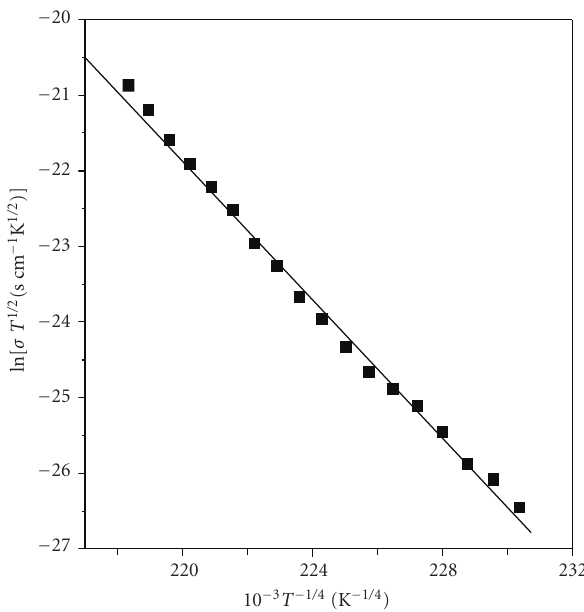
Figure 9: Plot of ln( σT 1 / 2 ) versus ( T − 1 / 4 ) for NFSC within a temperature of 350K–440 K and applied electric field of 2.25 Kv/cm.